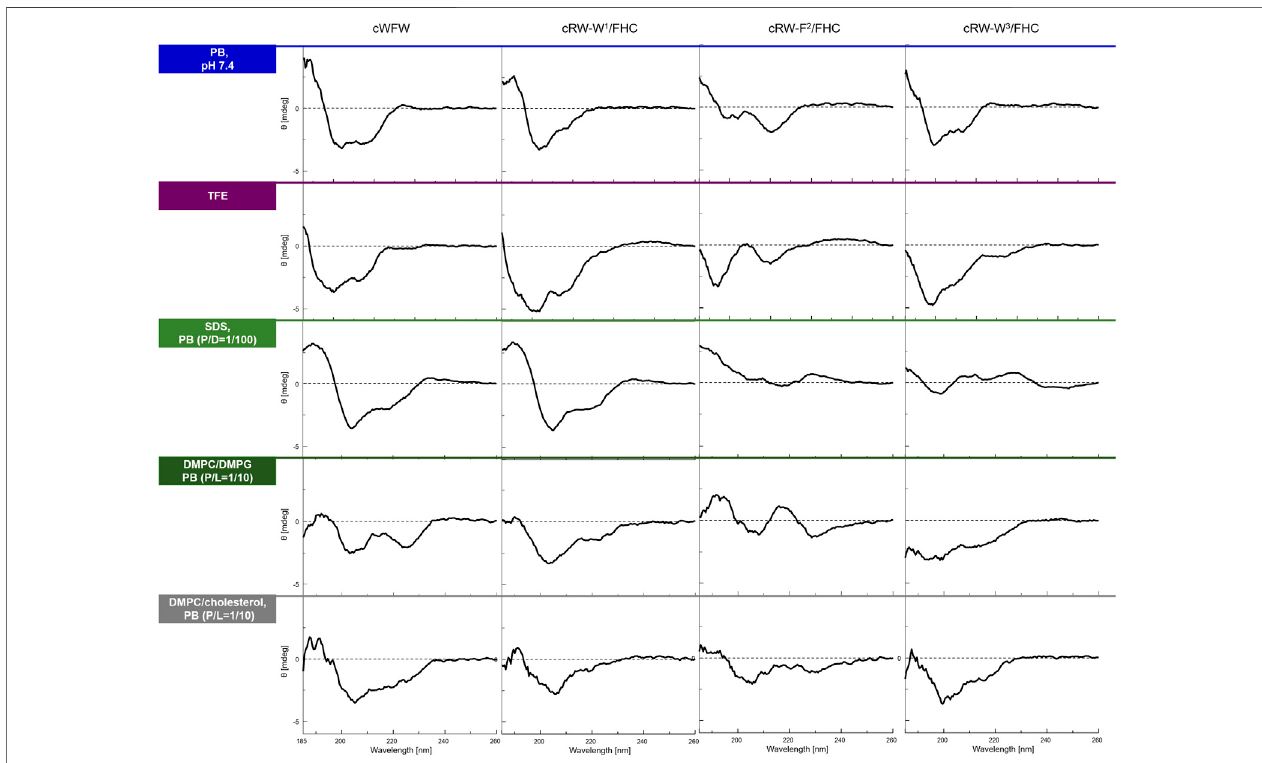
FIGURE2| CDspectraofthepeptidesinvariousenvironments(toptobottomtraces):in10 mMphosphatebuffer,pH7,4,in2,2,2-tri fl uoroethanol(TFE),in10 mM sodium dodecyl sulphate (SDS) micelles at a peptide/detergent ratio (P/D) of 1/100, in the presence of large unilamellar vesicles (LUVs) modeling an “ animal ” (DMPC/ cholesterol, 4/1) or a “ bacterial ” (DMPC/DMPG, 1/1) plasma membrane in terms of the lipid composition. The spectra were acquired from fresh 100 µM (or 200 µM for LUVs) peptide solutions at 25 ° C or 35 ° C (LUVs). P/L designates peptide/lipid ratio.